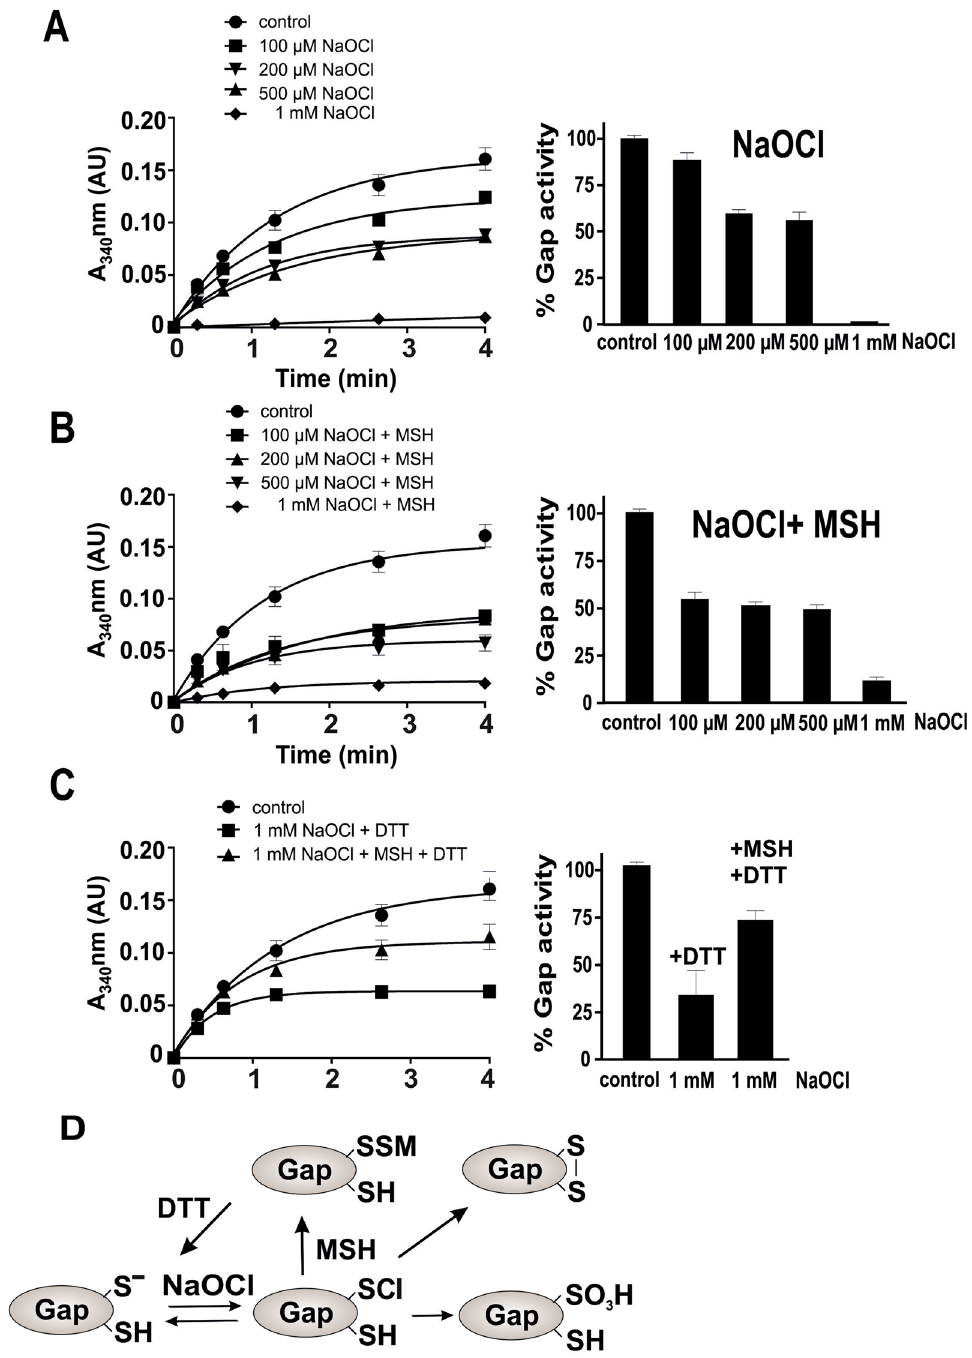
Figure 5. S -mycothiolation protects GapDH against overoxidation under NaOCl stress in vitro . (A , B) The NAD + -dependent GapDH activity was determined in a spectrophotometric assay by monitoring NADH generation during G3P oxidation at 340 nm. Inactivation of the GapDH activity was performed with 100, 200, 500 µ M and 1 mM NaOCl (A) without or (B) with MSH pre-treatment. (A , C) GapDH inactivation with 1 mM NaOCl alone is mostly irreversible due to the overoxidation of the active site to Cys sulfonic acid. (B , C) GapDH activity is reversibly inhibited due to S-mycothiolation with 1 mM NaOCl and MSH and could be reactivated by 10 mM DTT. The S -mycothiolation of Gap was confirmed by MSH-specific Western blots ( Figure S4). ( D) These results suggest that the GapDH active site Cys is chlorinated by NaOCl alone to form Cys-sulfenylchloride (-SCl) that reacts further to form Cys sulfonic acid and intramolecular disulfides in the absence of MSH. GapDH is protected against overoxidation by S -mycothiolation of the active site Cys in the presence of MSH. All data represent mean values of three independent replicate experiments and the error bars given were calculated as standard error of the mean